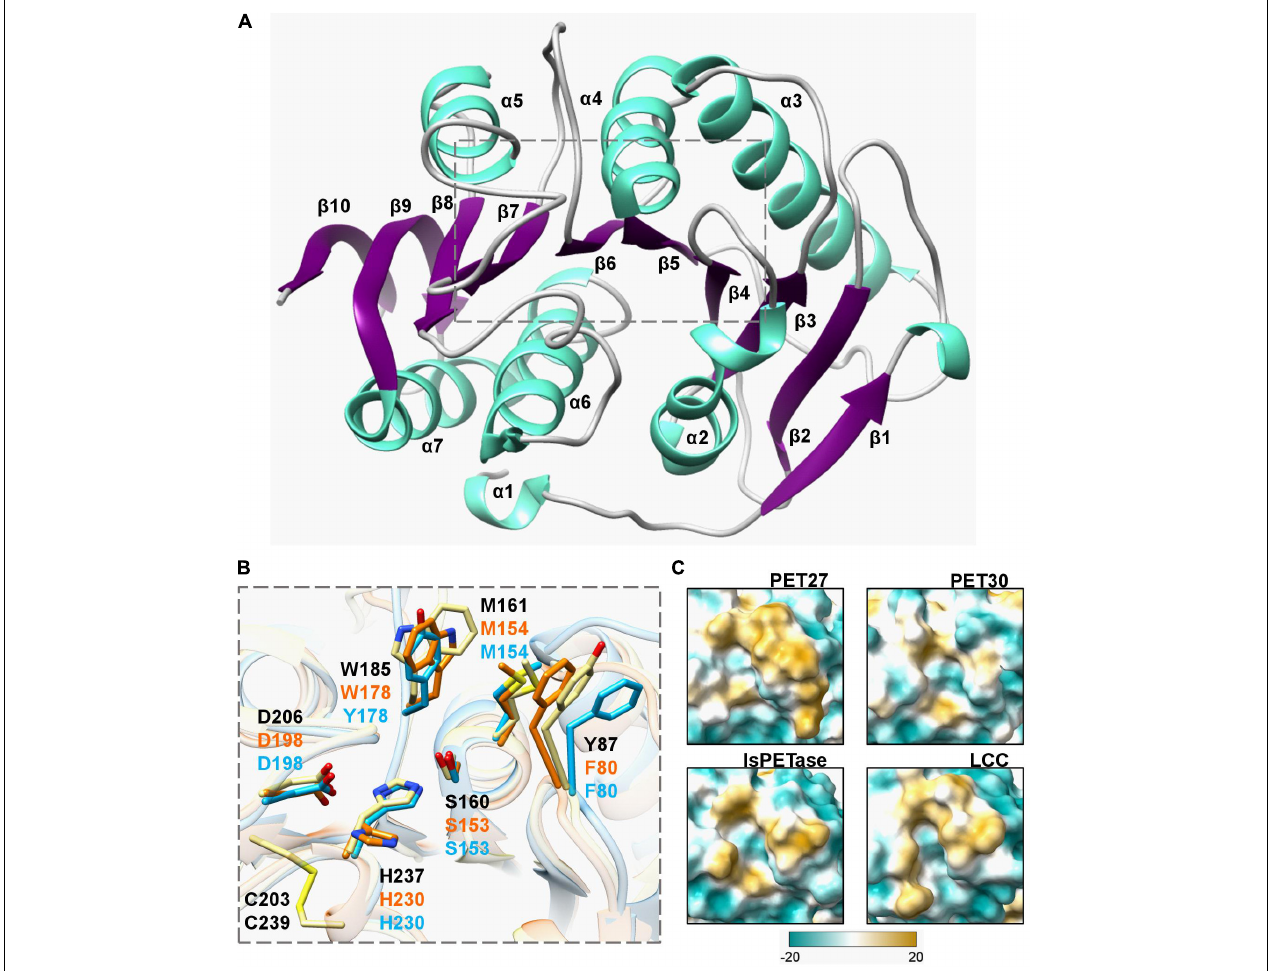
FIGURE 4 | Crystal structure of the PET-hydrolyzing bacteroidetal PET30 (cid:49) PorC including active site and hydrophobicity comparison. (A) Overall structure of PET30 (cid:49) PorC. The structure was solved by X-ray crystallography to a resolution of 2.1 Å and is shown as cartoon representation. Helices are colored in light turquoise and the beta-sheets are shown in purple. The number of the secondary structure elements are numbered according to the occurrence in the sequence. (B) Comparison of active site residues. All three enzymes PET30 (cid:49) PorC (light blue), PET27 (orange) and Is PETase (light yellow) have the typical residues of Ser-hydrolases at the catalytically active positions (Ser, His, and Asp), but PET27 and PET30 (cid:49) PorC differ in some of the amino acids associated with PET-binding. The residues of Is PETase are indicated in black. PET30 and PET27 lack a disulfide bridge in the proximity of a catalytic loop. Supplementary Figure 4 provides the positions of these residues in details on the amino acids level. The 3D structure of PET27 was modeled using the Robetta server (Kim et al., 2004) using the Is PETase crystal structure (6EQE) as a backbone. (C) Surface hydrophobicity around the tunnel leading to the active site of four PET-degrading enzymes. Hydrophilic regions are displayed in turquoise and hydrophobic in